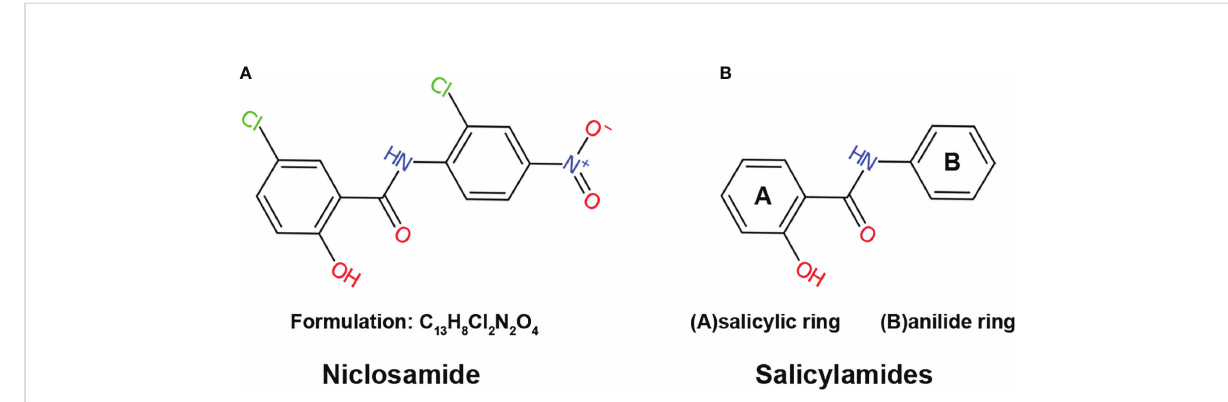
FIGURE 1 The structure of niclosamide (A) The structure and formulation of niclosamide. (B) The structure of salicylamides, which are weakly acidic phenolic compounds consisting of two basic chemical structures: a salicylic acid ring and an anilide